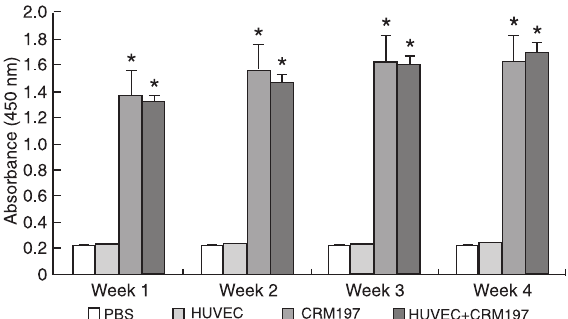
Figure 3. Detection of anti-CRM197 antibodies in immunized mice. Anti-CRM197 antibodies were detected by ELISA as early as 1 week after immunization in the sera of animals immunized with CRM197 and other immunized groups. Antibody levels peaked 2 weeks after immunization. The anti-CRM197 level from the groups vaccinated with CRM197 (CRM197 alone and CRM197+viable HUVECs) showed a significant increase com- pared with those from the PBS group and the HUVEC group (*P < 0.05, Student t -test), but there were no differences between these two groups, which were vaccinated with CRM197 or HUVECs+CRM197 (N = 8 animals per group). Data are reported as means ± SD. HUVECs = human umbilical vein endothelial cells; CRM197 = nontoxic diphtheria toxin.